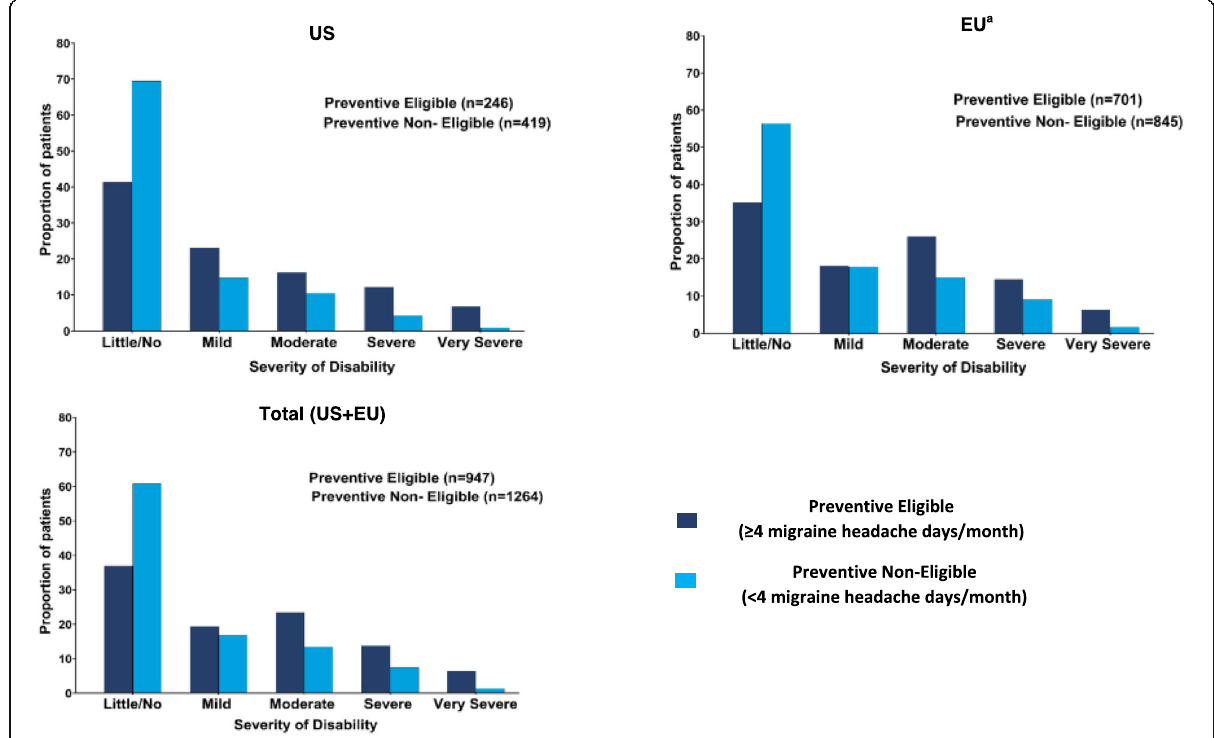
Fig. 2 Migraine disability grade per the MIDAS (%) by preventive treatment eligibility